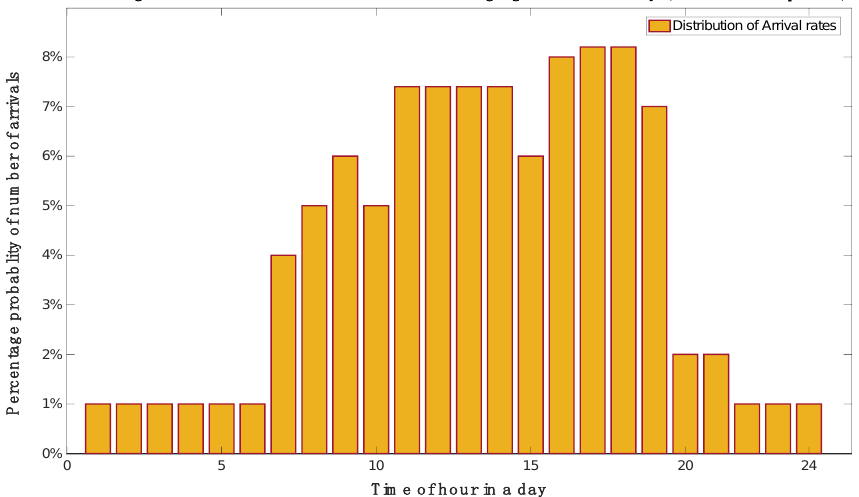
Percentage Distribution of EV Arrival Rates at Charging Station in a Day (24 hours time period)